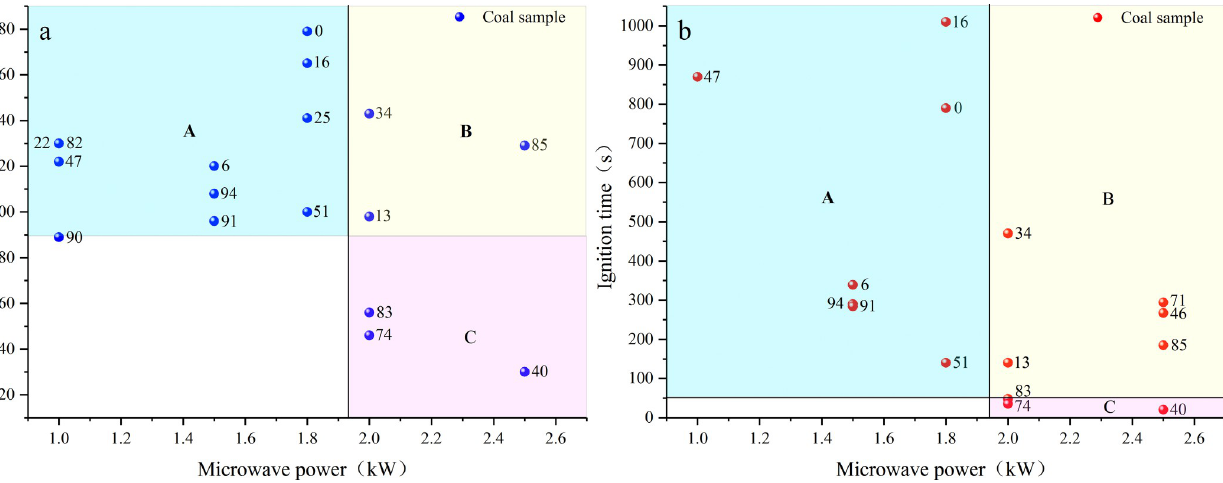
PLOS ONE | https://doi.org/10.1371/journal.pone.0283434 April 12,